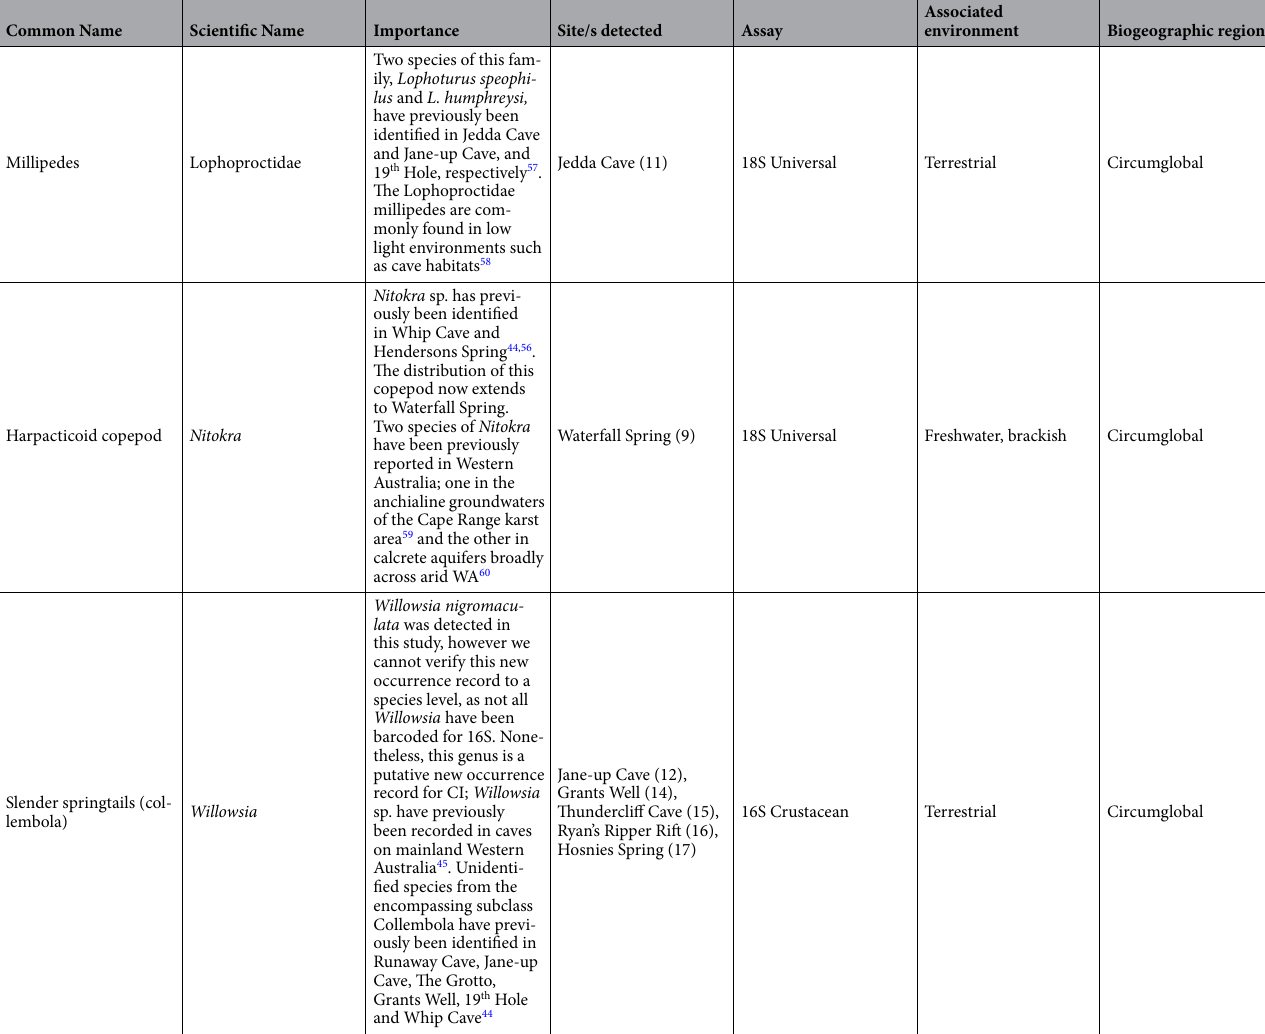
Table 3. Taxa of conservation, biodiversity and biosecurity importance. Site number is given in parentheses next to site name.